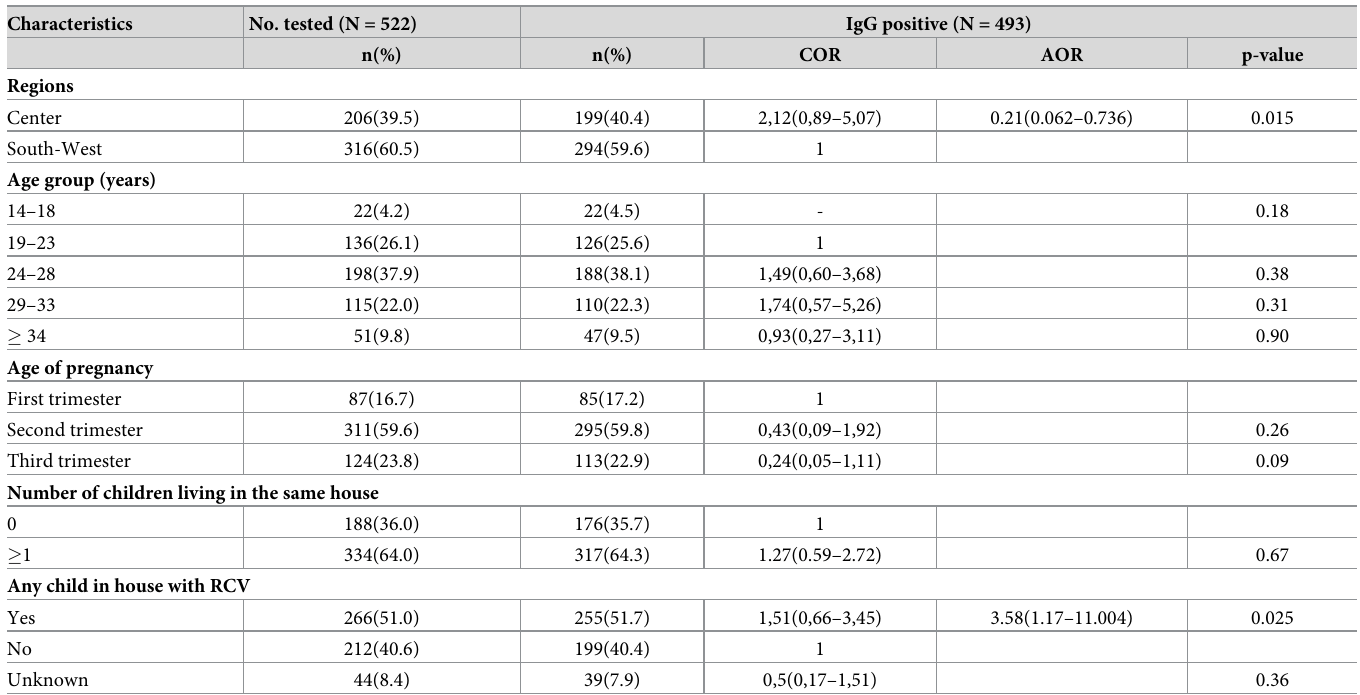
Table 1. Association between rubella antibodies and characteristics of pregnant participants. Characteristics